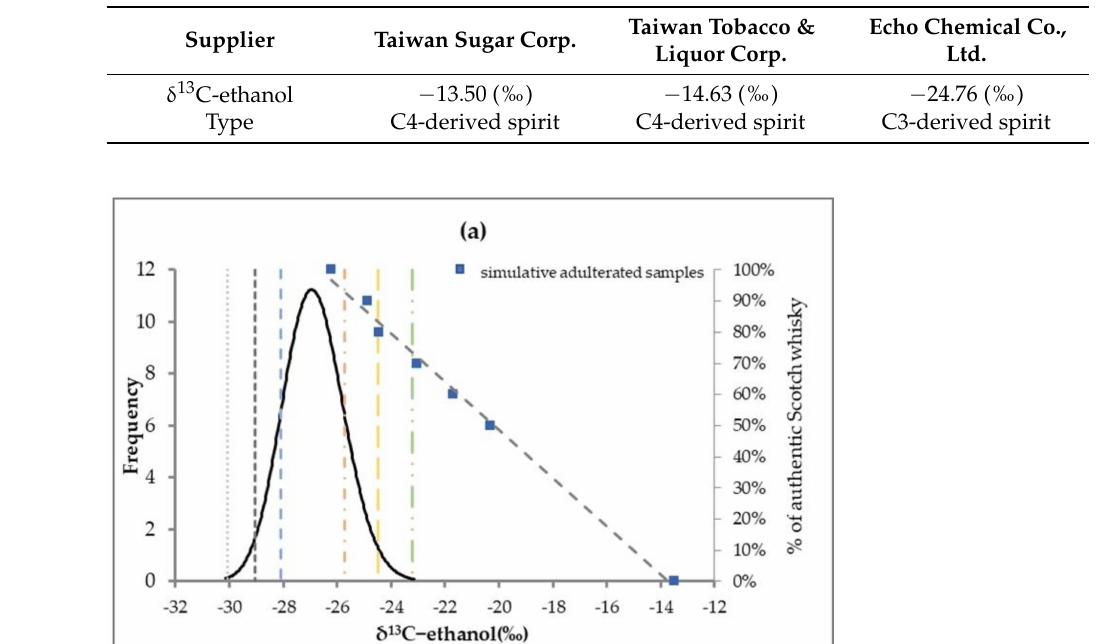
Table 4. δ 13 C-ethanol data of commonly-used edible rectified spirit in Taiwan.